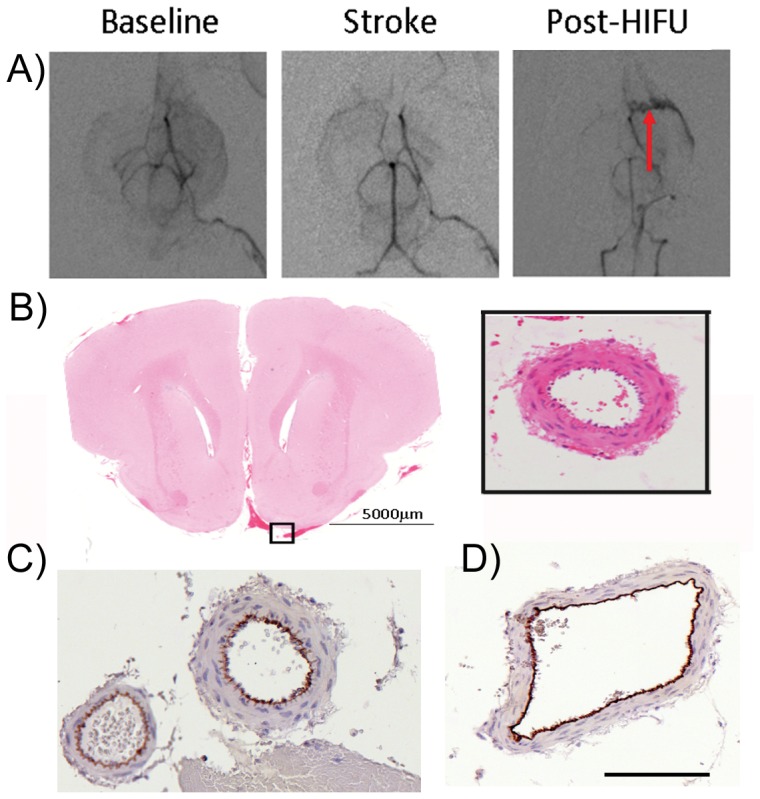
HIFU (550 W) recanalizes ∼70% of blocked vessels with no arterial injury.In most animals treated with 550 W, recanalization, similar to what was achieved with 415 W was observed. A) In one animal, a greater extent of recanalization was achieved but was accompanied by an apparent tortuous MCA vessel suggesting some damage occurred to the MCA during sonication. B) Histological analysis from these animals revealed minor bleeding at the base of the brains; however the MCA appeared intact in these sections (inset). C) CD31 immunohistochemistry labeled endothelial cells and confirmed that the arteries and arterioles are viable in the sonicated regions. Scale bar (B inset, C, D) = 500 µm.